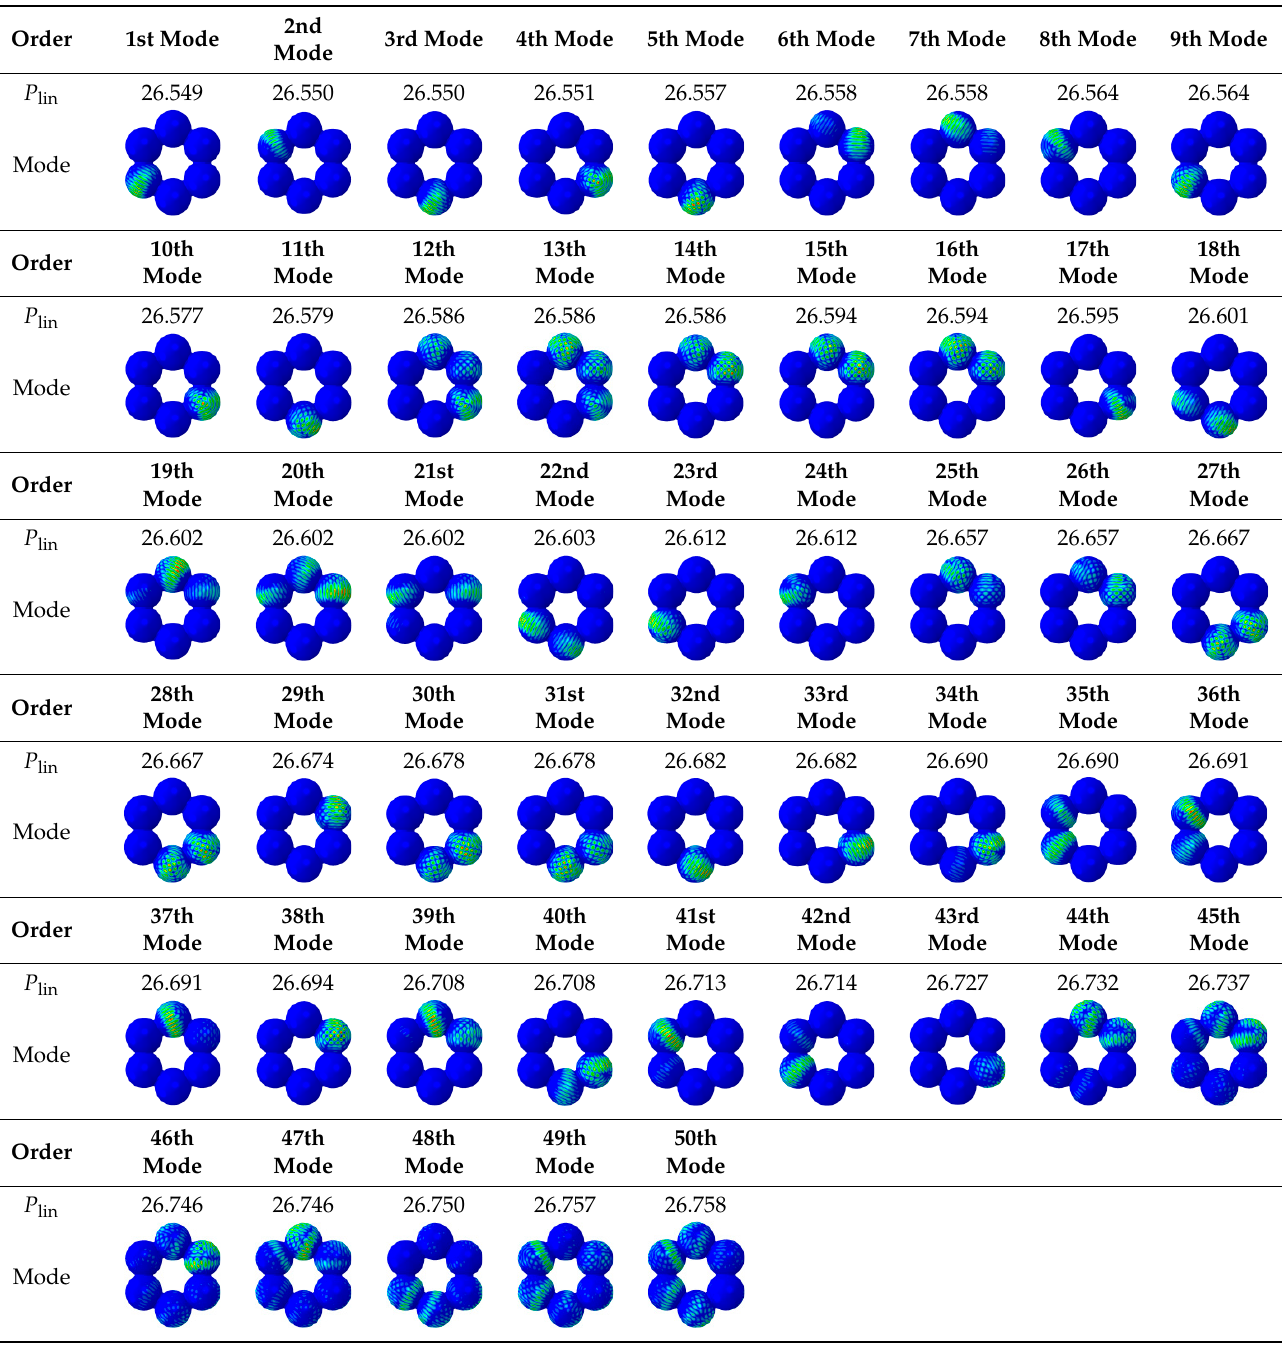
Table 2. First 50th linear buckling loads and eigenmodes of sphere-segmented toroidal shells.